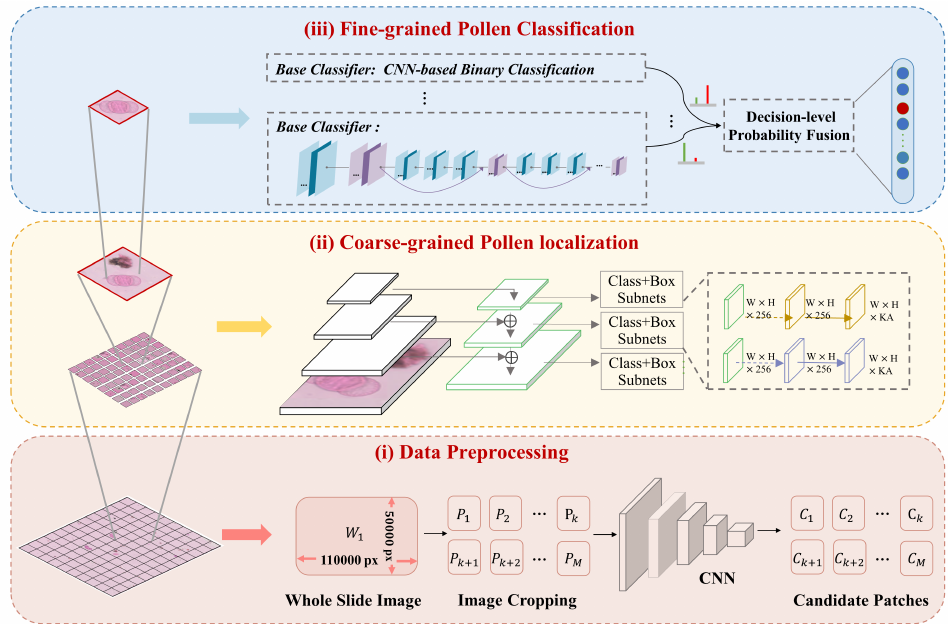
Figure 5. The overall network architecture of our proposed